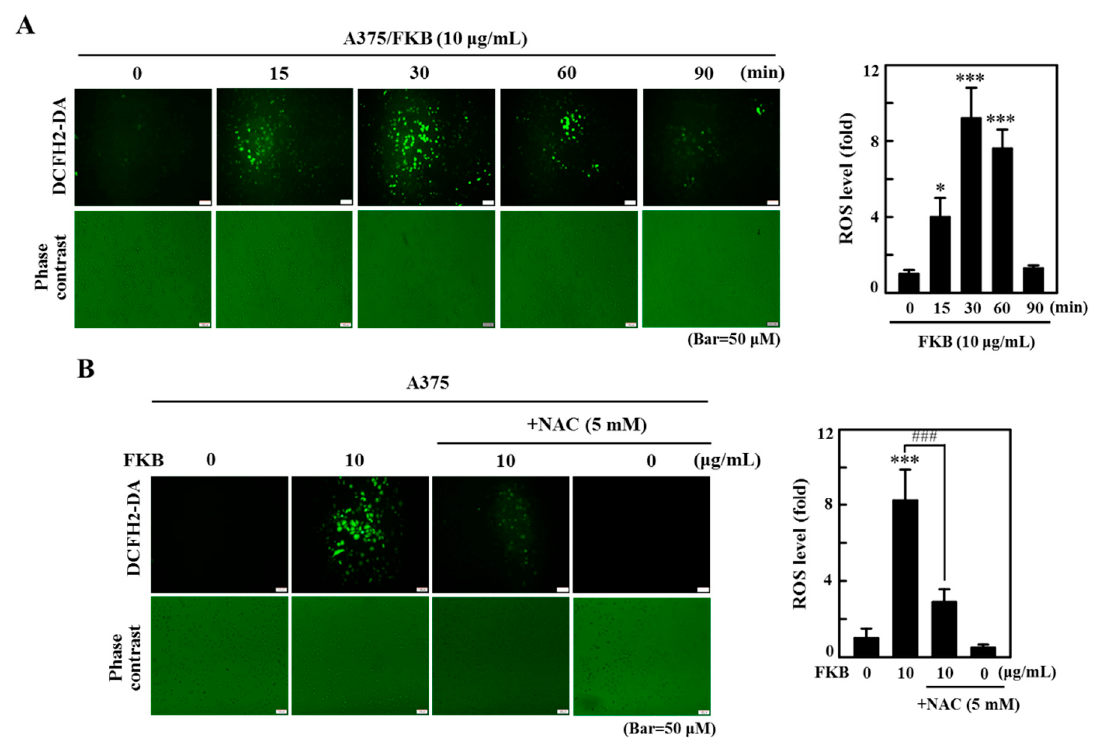
Figure 9. Intracellular ROS was induced by FKB in A375 cells. ( A ) A375 cells were treated with FKB (10 µg/mL) for 0–90 min. ( B ) Cells were pretreated with or without 5 mM N -acetylcysteine (NAC) (a ROS inhibitor) for 1 h followed by FKB (10 µg/mL) for 30 min. The non-fluorescent probe 2 ′ - 7 ′ dichlorofluorescin diacetate (DCFH 2 -DA) was used to measure the intracellular ROS generation. DCFH 2 -DA reacted with cellular ROS and metabolized into fluorescent dichlorofluorescein (DCF), which was proportionate to the generation of ROS. The data were represented as fold-over change in the ROS levels compared to the control, which was arbitrarily assigned as one. Each value was expressed as mean ± standard deviation (SD) of three experiments. Statistical significance was assigned as * p < 0.05 and *** p < 0.001 compared to untreated control cells. ### p < 0.001 compared to FKB alone treated cells.